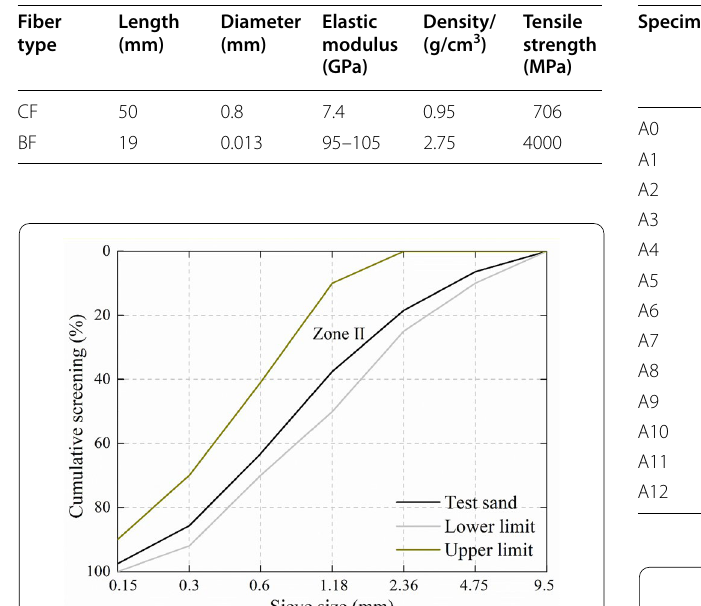
Table 1 Properties of fibers.